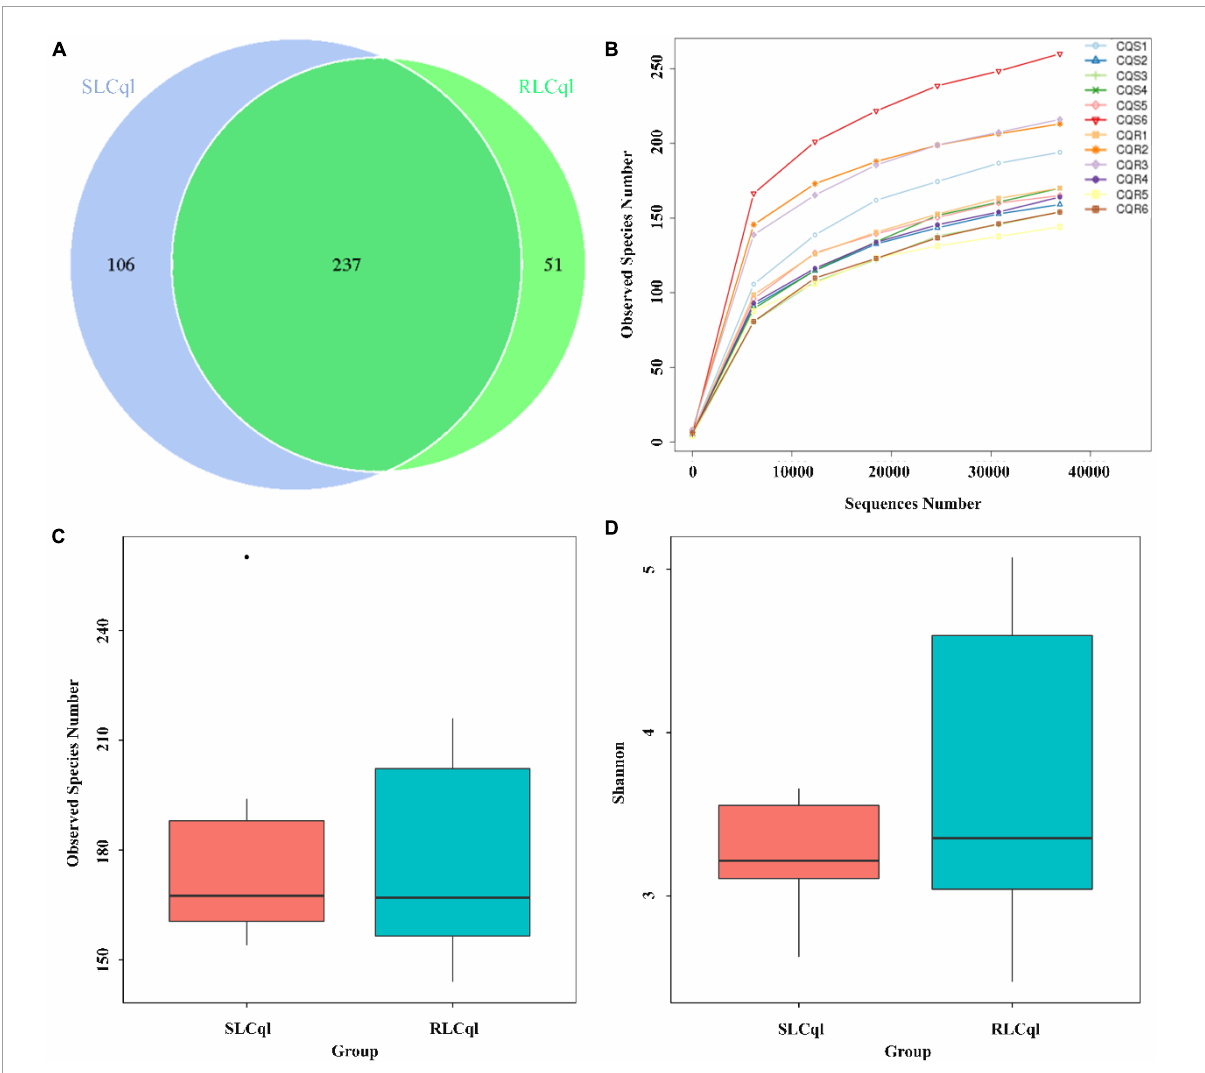
FIGURE1 Alpha diversity of symbiotic gut bacteria from strains that are susceptible and resistant to Lysinibacillus sphaericus C 3 -41 [ (A) Venn Graph, (B) Rarefaction curve, (C) Observed species, (D) Shannon index].